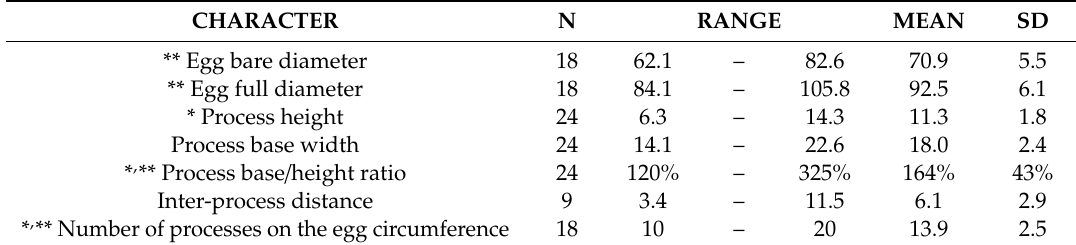
Table 8. Measurements (in µ m) of selected morphological structures of eggs of the American (Alaskan) population of Paramacrobiotus fairbanksi Schill, Förster, Dandekar and Wolf [25] mounted in Hoyer’s medium (N, number of eggs / structures measured; RANGE refers to the smallest and the largest structure among all measured eggs; SD, standard deviation). * except of values of ratio which is presented as percentage and number of processes on the egg circumference which is as number; ** measurement based partially on Schill et al. [25].